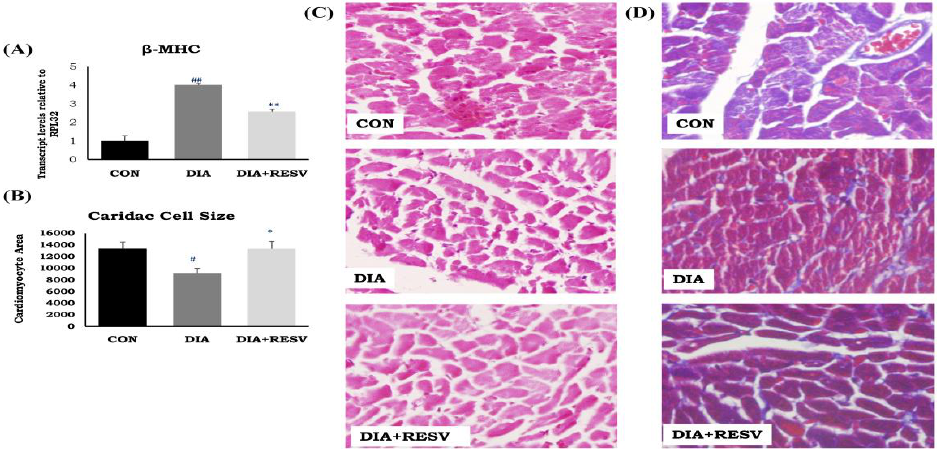
Figure 1. Cardiac phenotypes and histopathological changes in diabetic rat heart and effect of resveratrol administration . ( A ) mRNA expression of β -MHC; ( B ) Cardiac cell size; ( C ) Hematoxylin and eosin staining of rat heart tissue; ( D ) Masson’s trichrome staining of rat heart tissue. Data shown as Mean ± SE, ( n = 6) # p < 0.05, ## p < 0.01 vs. Con; * p < 0.05, ** p < 0.01 vs. DIA group. Three sections were observed for histopathology examination and twenty cells per image were analyzed for cell size